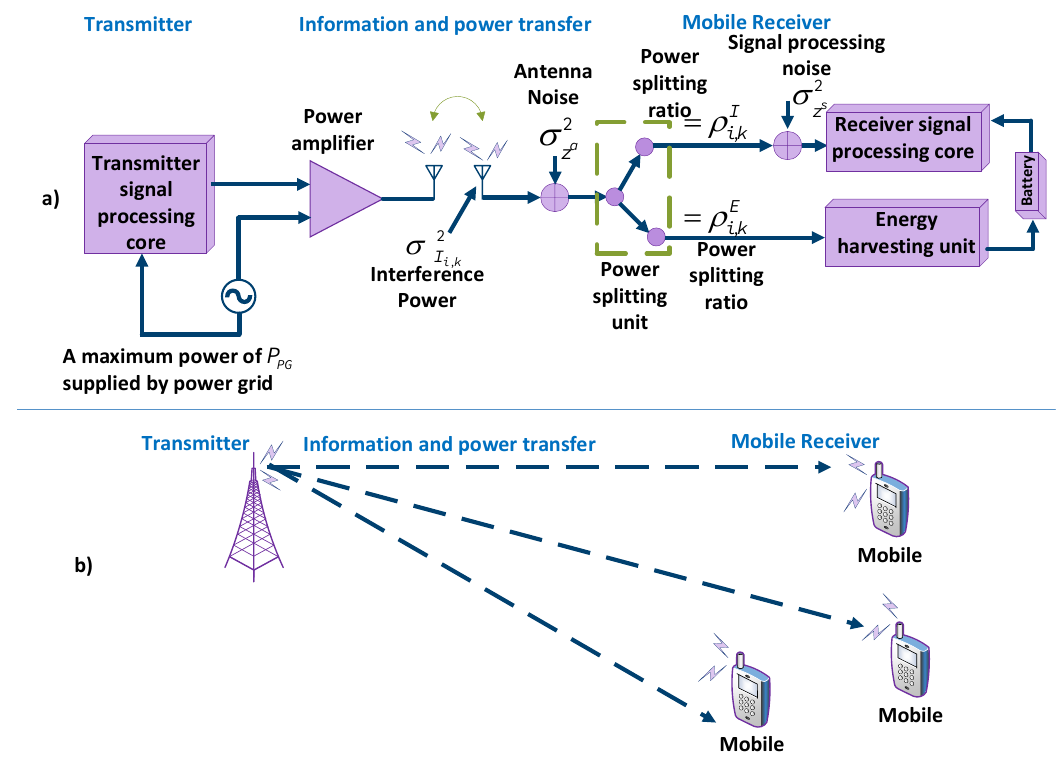
Figure 27. OFDMA in BackCom. ( a ) Block diagram of the transceiver model for wireless power and information transfer; ( b ) OFDMA downlink communication system with various mobile